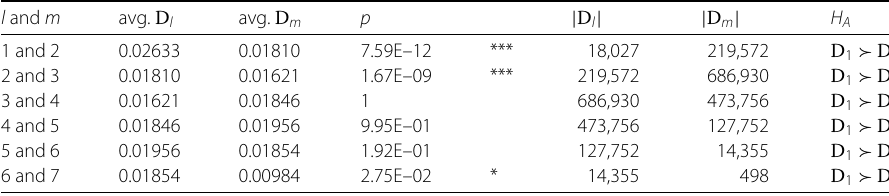
Table 2 One-sided independent two-sample Welch’s t -test on the difference in trade synchronization score for pairwise consecutive social distance. Here, D k is the set of the synchronization scores between investors at the distance k l and m avg. D l avg. D m p | D l | | D m | H A 1 and